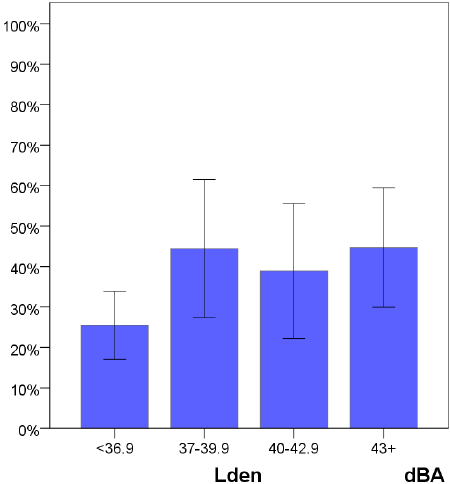
Figure 3. Response rate (blue) as a function of noise exposure (four intervals). Lista wind farm 2015. (Error bars denote 95% confidence intervals).